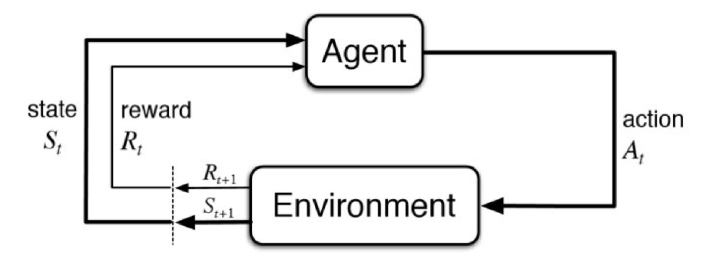
Figure 9. A typical structure of a reinforcement learning network